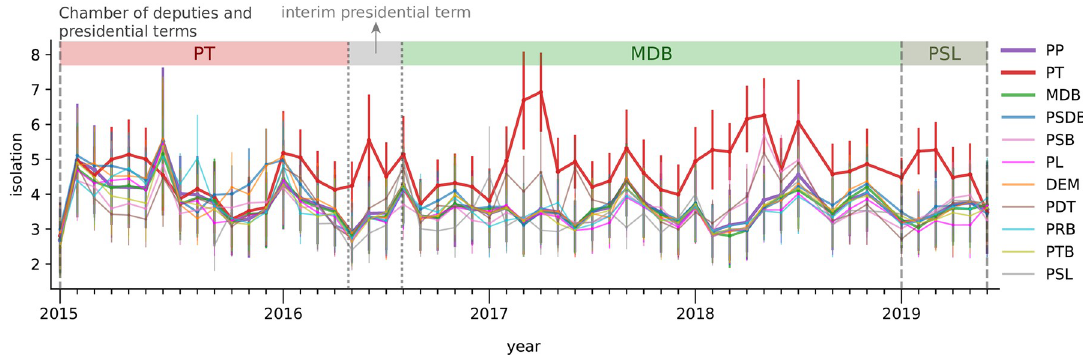
Fig 11. Isolation of political parties few months before and after impeachment. The isolation of parties is computed using Eq 11. PT turned out to be the most isolated party a few months before impeachment. The relative isolation became stronger after 2017.